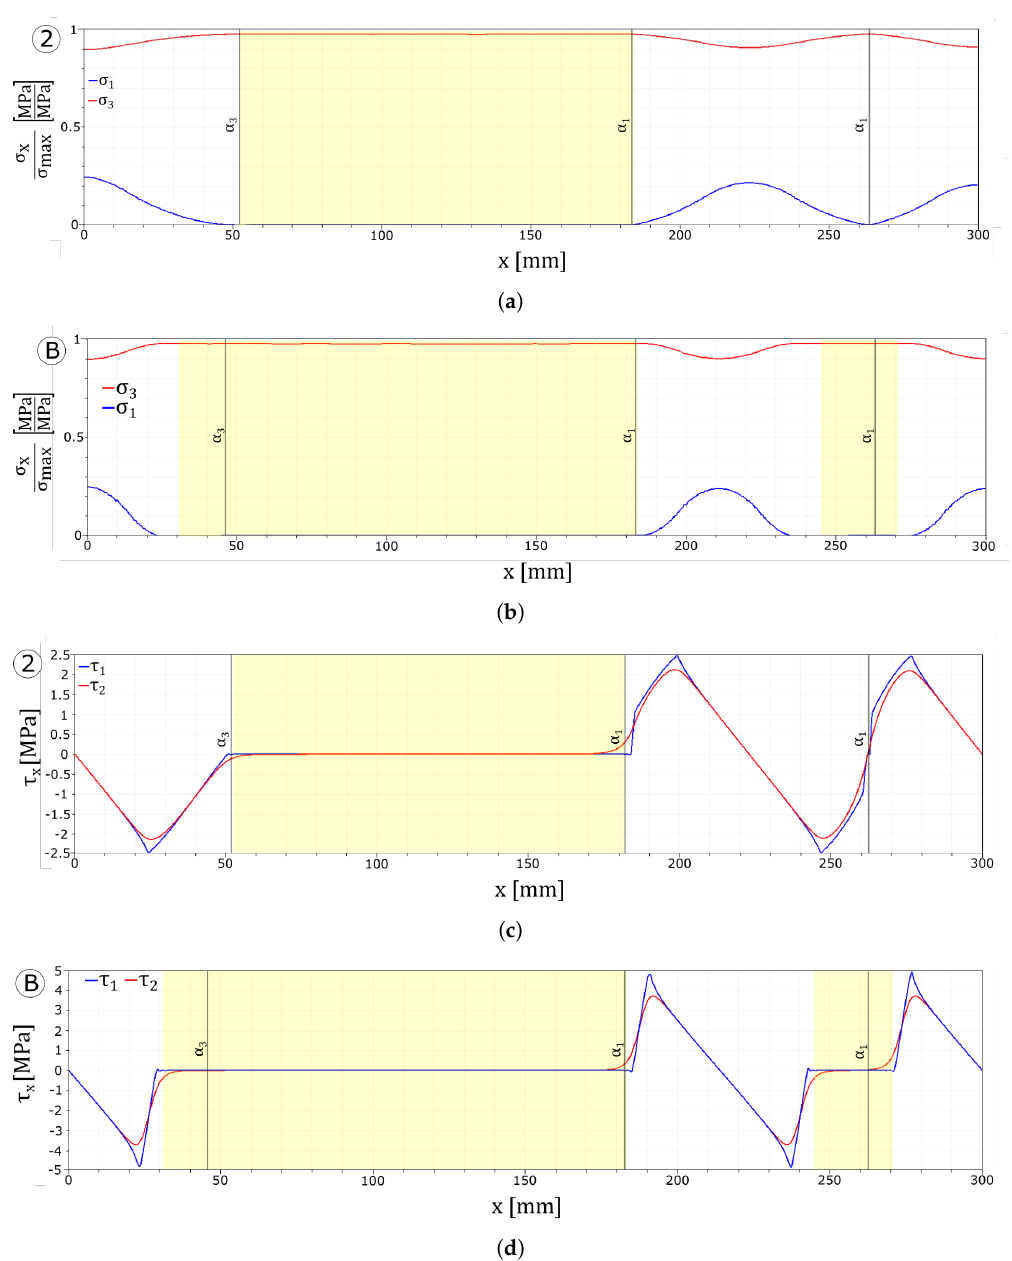
Figure 11. Numerical results: stress plots. ( a ) UD tau2.5 glass plies stress profiles. ( b ) UD d2 glass plies stress profiles. ( c ) UD tau2.5 interface stress profiles. ( d ) UD d2 interface stress